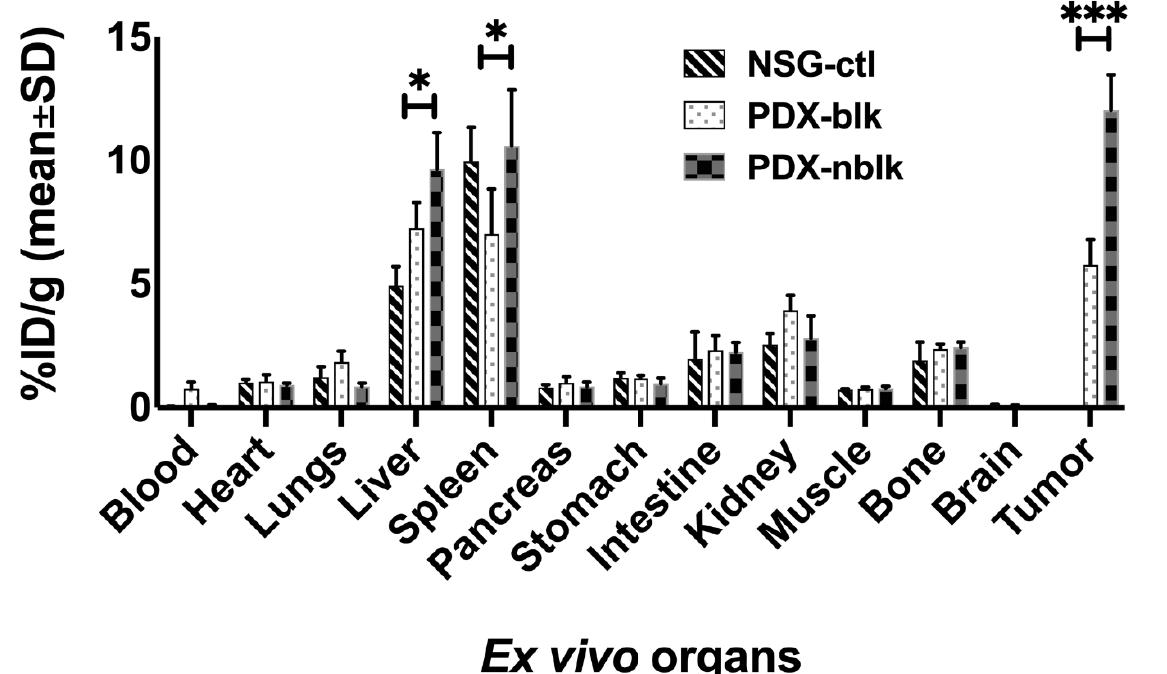
Figure 5. Biodistribution measurements of 89 Zr-Df-H3K3 tracer uptake. Major organs were harvested at 168 h p.i. of 89 Zr-Df-H3K3, and ex vivo tracer uptake into each organ was measured using the gamma counter: NSG liver (Ctl); PDX mice liver-tumor blocked with pre-dose (Blk), and non-blocking liver-tumor (Nblk). Data are presented as mean ± SD %ID/g in four mice per group (NSG-ctl with non-tumor bearing liver; PDX-NSG-blk for blocking group; and PDX-NSG-nblk for non-blocking group). * p = 0.05, *** p = 0.001.